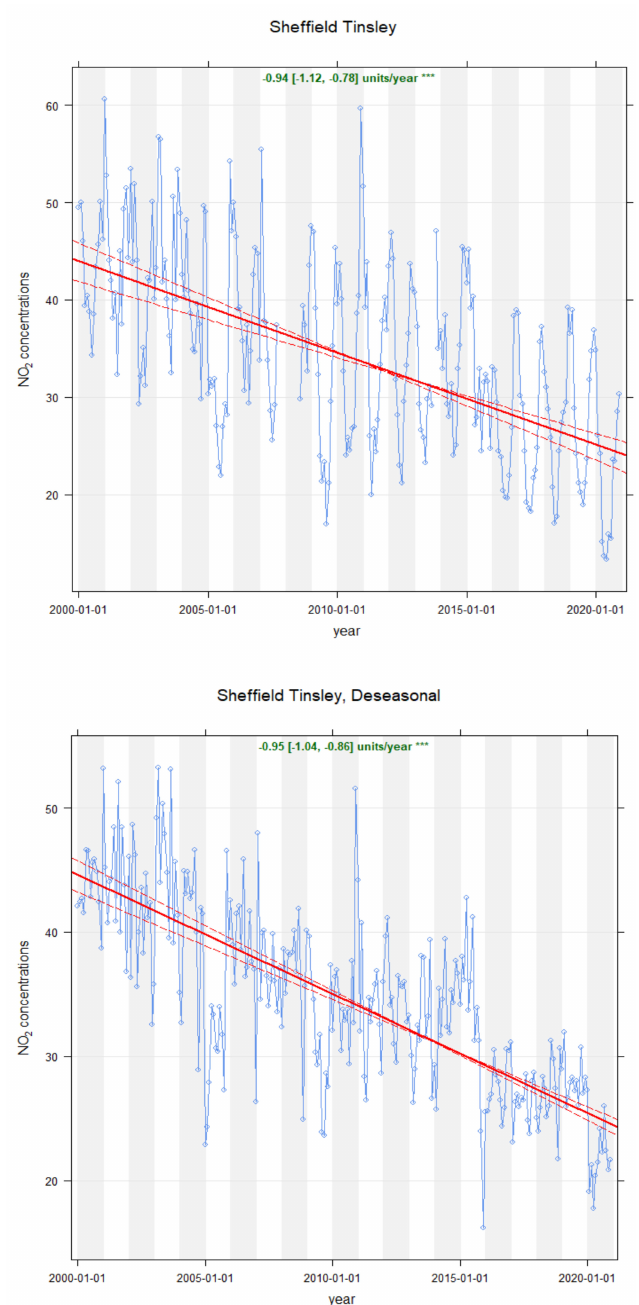
Figure 13. Long-term temporal trend for NO 2 concentrations ( µ g/m 3 ) (2000–2019) at the Sheffield Tinsley site, one of the AURN sites. *** shows that the trend is highly